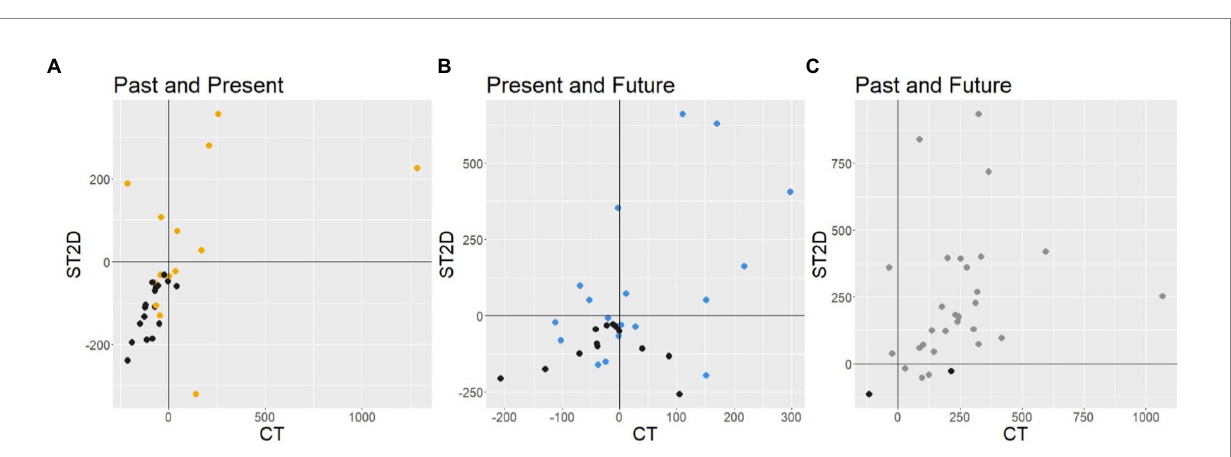
FIGURE 9 Distance between the surfaces of spheres in ST as a function of the distance between surfaces of circles in CT. Each dot expresses the past, present, and future positions of a participant. Black dots indicate that the two spheres are attached to each other in the 3D space in ST. (A) Past-Present distance on the screen in ST. (B) Present-Future distance on the screen in ST. (C) Past-Future distance on the screen in